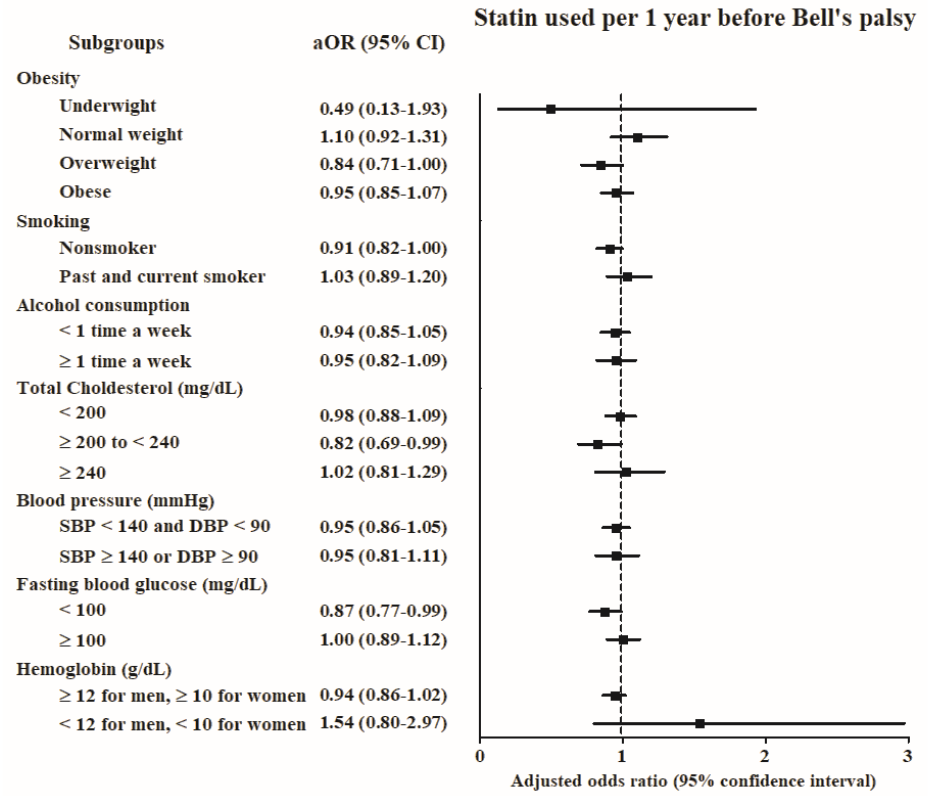
Figure 2. Odds ratios (95% confidence interval) of statin use against Bell’s palsy, according to age, sex, smoking, alcohol consumption, total cholesterol, blood pressure, fasting blood glucose, and hemoglobin.